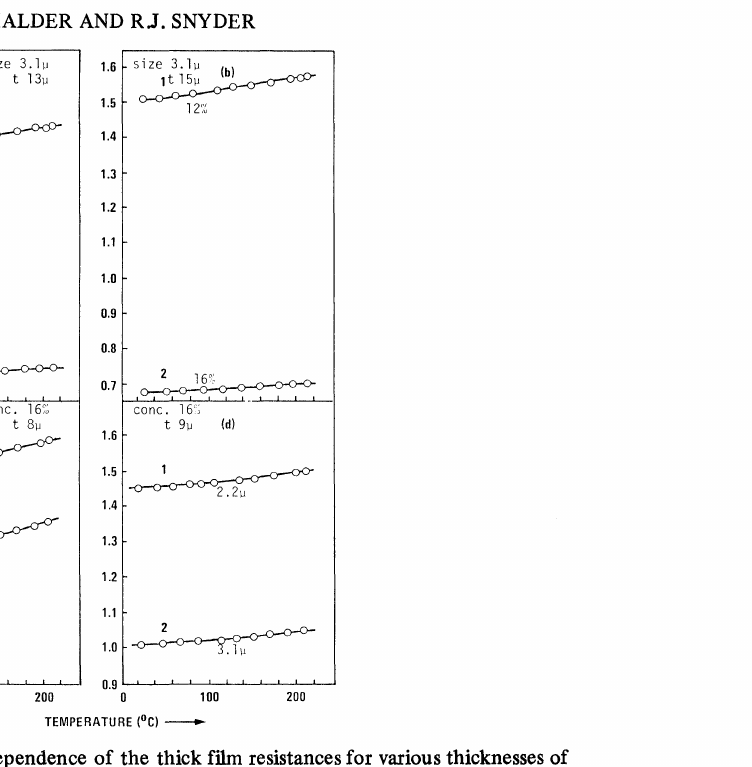
FIGURE 4 Measured temperature dependence of the thick film resistances for various thicknesses of the resistors, sizes and concentration of the particles. (a) 13/ and 3.1#; (b) 15 and 3.1#; (c) 8 and 16%" (d) 9 and 16%. The results obtained are summarized in Table